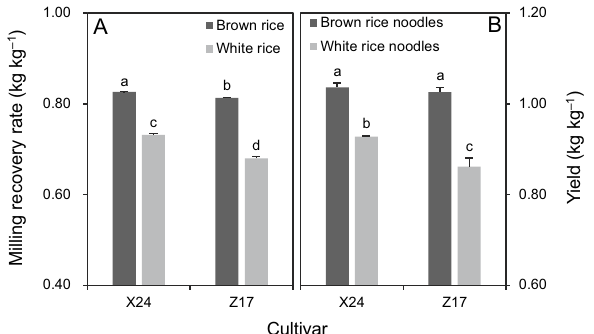
Figure 1. Milling recovery rate of brown and white rice ( A ) and yield of brown and white rice noodles ( B ) processed from two rice cultivars, Xiangzaoxian 24 (X24) and Zhongjiazao 17 (Z17). Data are mean ± SE ( n = 3). Bars sharing the same lowercase letters are not significantly different at the 0.05 probability level.